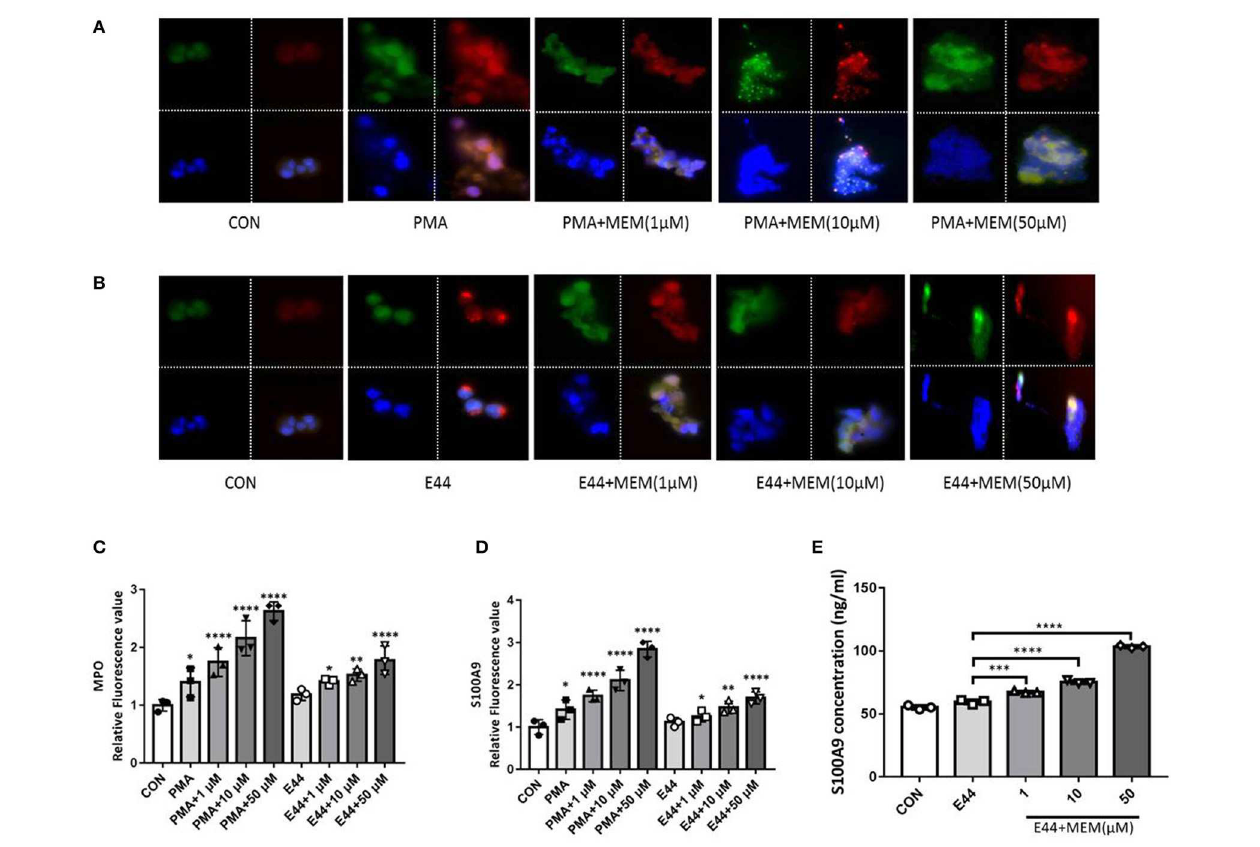
FIGURE 5 | MEM promoted the expression of bactericidal enzyme MPO and antiseptic protein S100A9. The PMNs were treated with PMA, E. coli E44, different dose of MEM, and then incubated with fluorescent conjugated antibodies of MPO and S100A9, and the cell nucleus was stained with DAPI. (A) Expression of MPO and S100A9 in cells treated with PMA or PMA in combination with different concentration of MEM; (B) Expression of MPO and S100A9 in cells treated with E44 and different concentration of MEM; (C) Quantitative analysis of the relative fluorescence value of MPO induced by PMA, E44, and MEM; (D) Quantitative analysis of the relative fluorescence value of S100A9 induced by PMA, E44, and MEM; (E) Expression level of S100A9 in culture medium induced by E44 or/and MEM. A total of 1 × 10 6 of PMNs were cultured in 24-well plates, and treated with E. coli E44 or/and different dose of MEM for 2h. Then the samples were collected and centrifuged. The S100A9 in the supernatant was detected using the S100A9 ELISA kit according to the manufacturer’s instructions. Each bar represents the average of three different experiments ± SD. Scatter plots in the bar graphs represent the three biological replicates. * P < 0.05, ** P < 0.01, *** P < 0.001, **** P < 0.0001 compared with the control. Colors: MPO is shown in green; S100A9 is shown in red; Cell nucleus stained with DAPI is shown in blue.